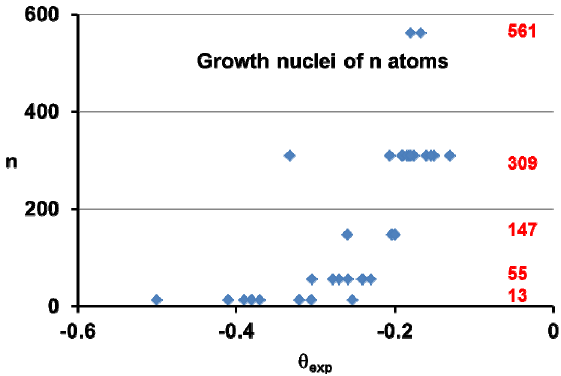
Figure 4. N -atom superclusters acting as growth nuclei versus the experimental reduced undercooling temperatures. The number n of atoms of superclusters is plotted versus the experimental reduced temperature of crystallization θ c exp